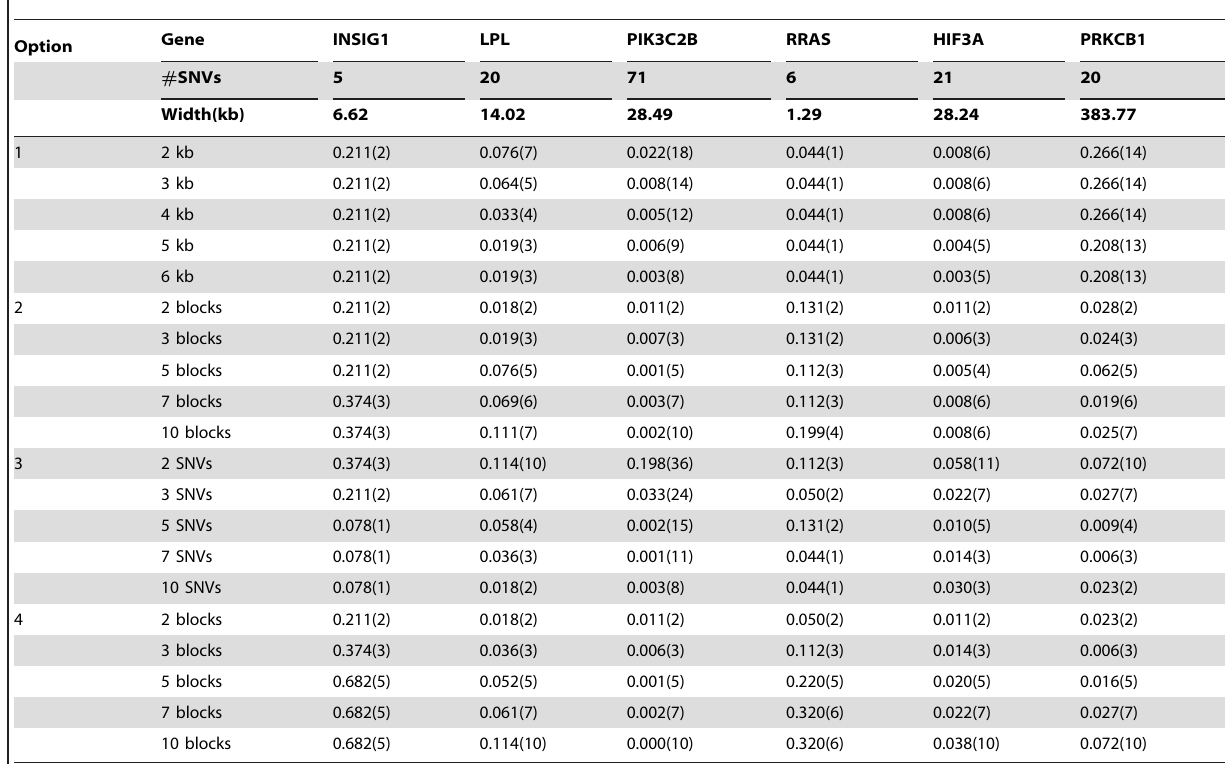
Table 2. List of p-values for six causal genes for different options with a variety of partitioning choices.